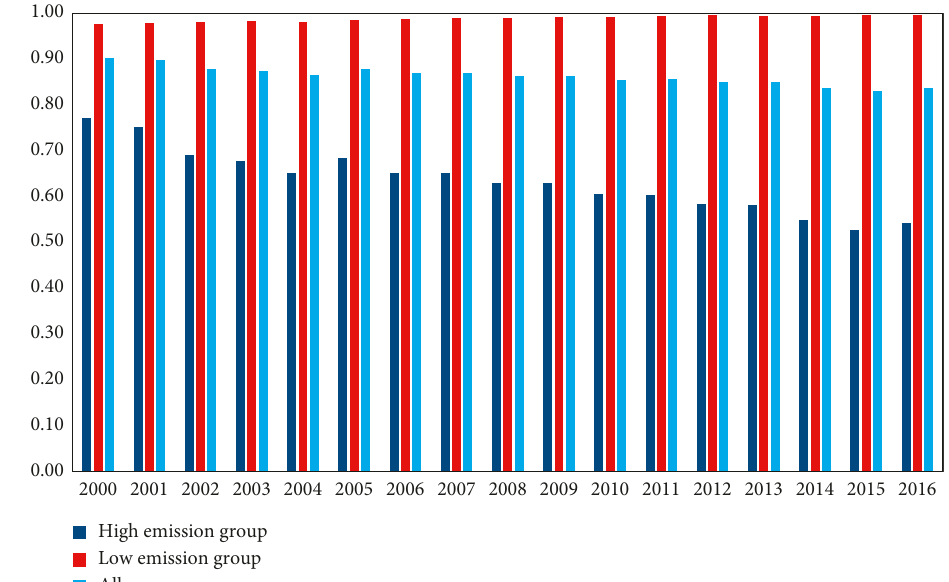
Figure 2: Trends in metafrontier ratio of different